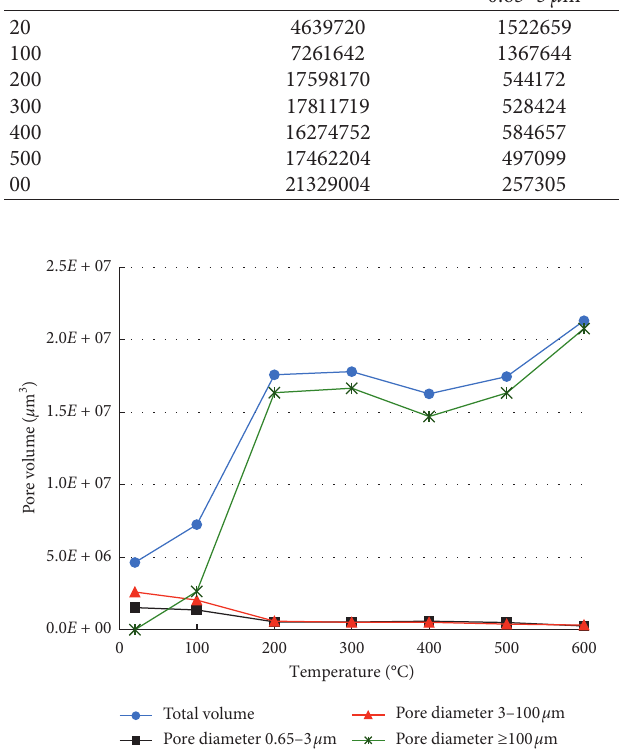
Figure 9: Variations in volume of pores with different diameters with temperature.